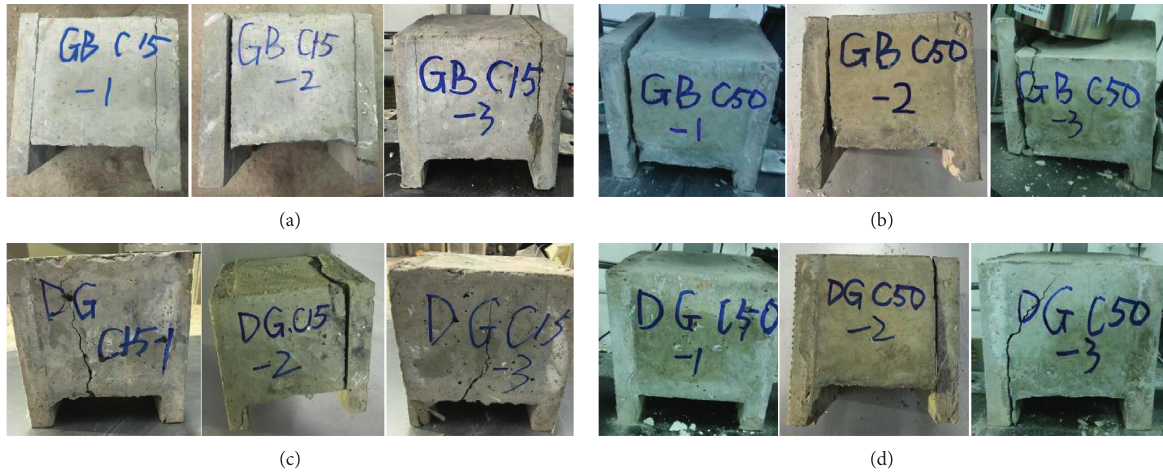
Figure 6: Failure characteristics of the composite samples after the shear test: (a) GB C15, (b) GB C50, (c) DG C15, and (d) DG